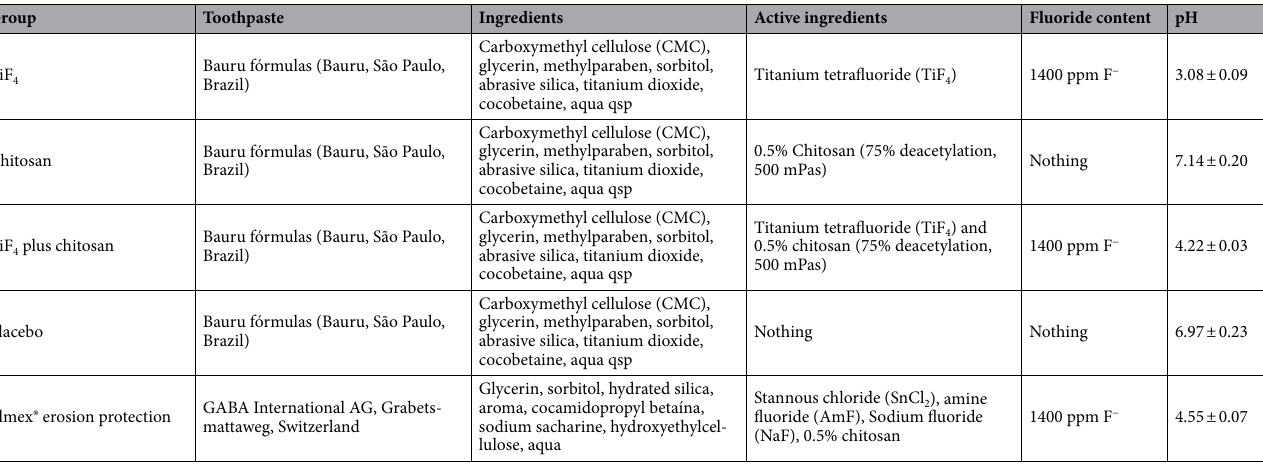
Table 1. Composition of the toothpastes under study (according to information available in the label) and their respective pH values (slurries’ pH, mean and